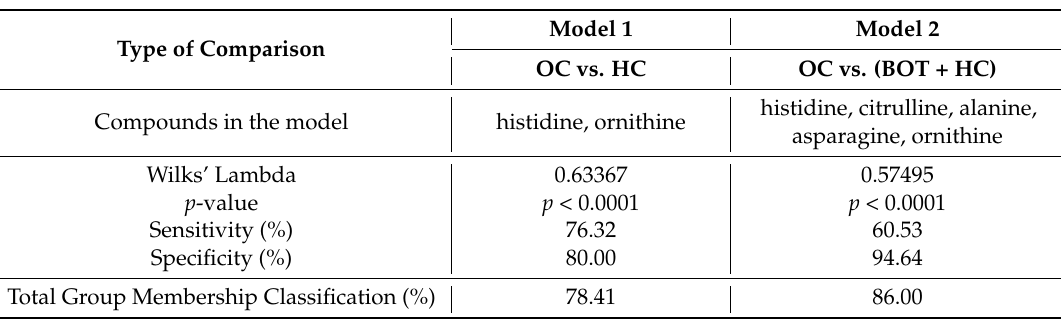
Table 1. Discriminant function analysis parameters for ovarian cancer (OC) versus healthy control (HC) group and OC versus combined benign ovarian tumor (BOT) and HC group.